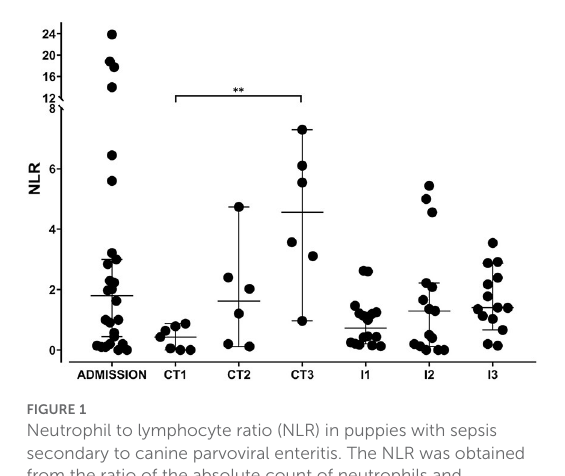
FIGURE1 Neutrophil to lymphocyte ratio (NLR) in puppies with sepsis secondary to canine parvoviral enteritis. The NLR was obtained from the ratio of the absolute count of neutrophils and lymphocytes in puppies with sepsis secondary to canine parvoviral enteritis treated with conventional treatment and those that received an immunomodulator as an adjuvant treatment. The graph shows NLR at admission and three subsequent days of treatment (critical time). Each dot represents a puppy. There are statistical differences between days 1 and 3 in the conventional treatment group. Kruskal–Wallis test,